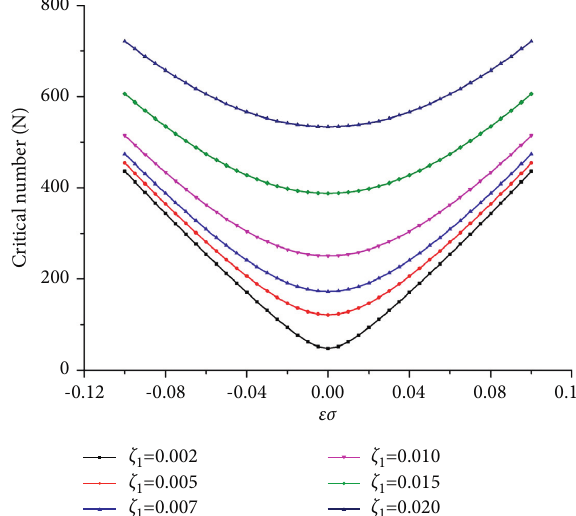
Figure 5: The relationship between critical number of pedestrians and pedestrian step frequency in different damping